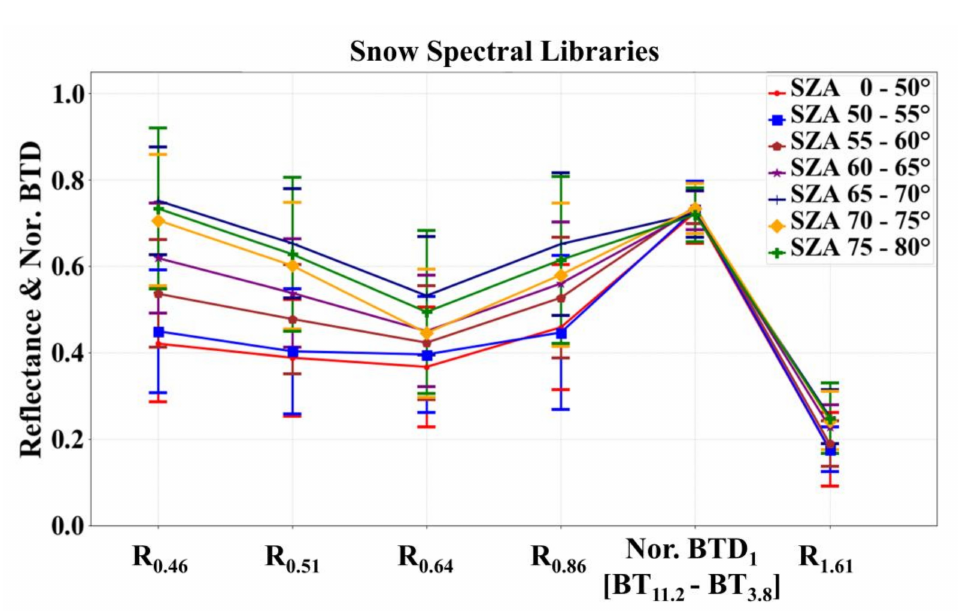
Figure 6. Snow spectral libraries using the reflectivity and brightness temperature of Himawri-8 / AHI and snowfall data reprojected to Himawri-8 / AHI full disk, 7 Snow spectral libraries according to SZA, X-axis of snow spectral libraries is R 0.46 , R 0.51 , R 0.64 , R 0.86 , BTD 1 , R 1.61 data, the Y-axis is the average value and standard deviation of the reflectance and BTD corresponding to the